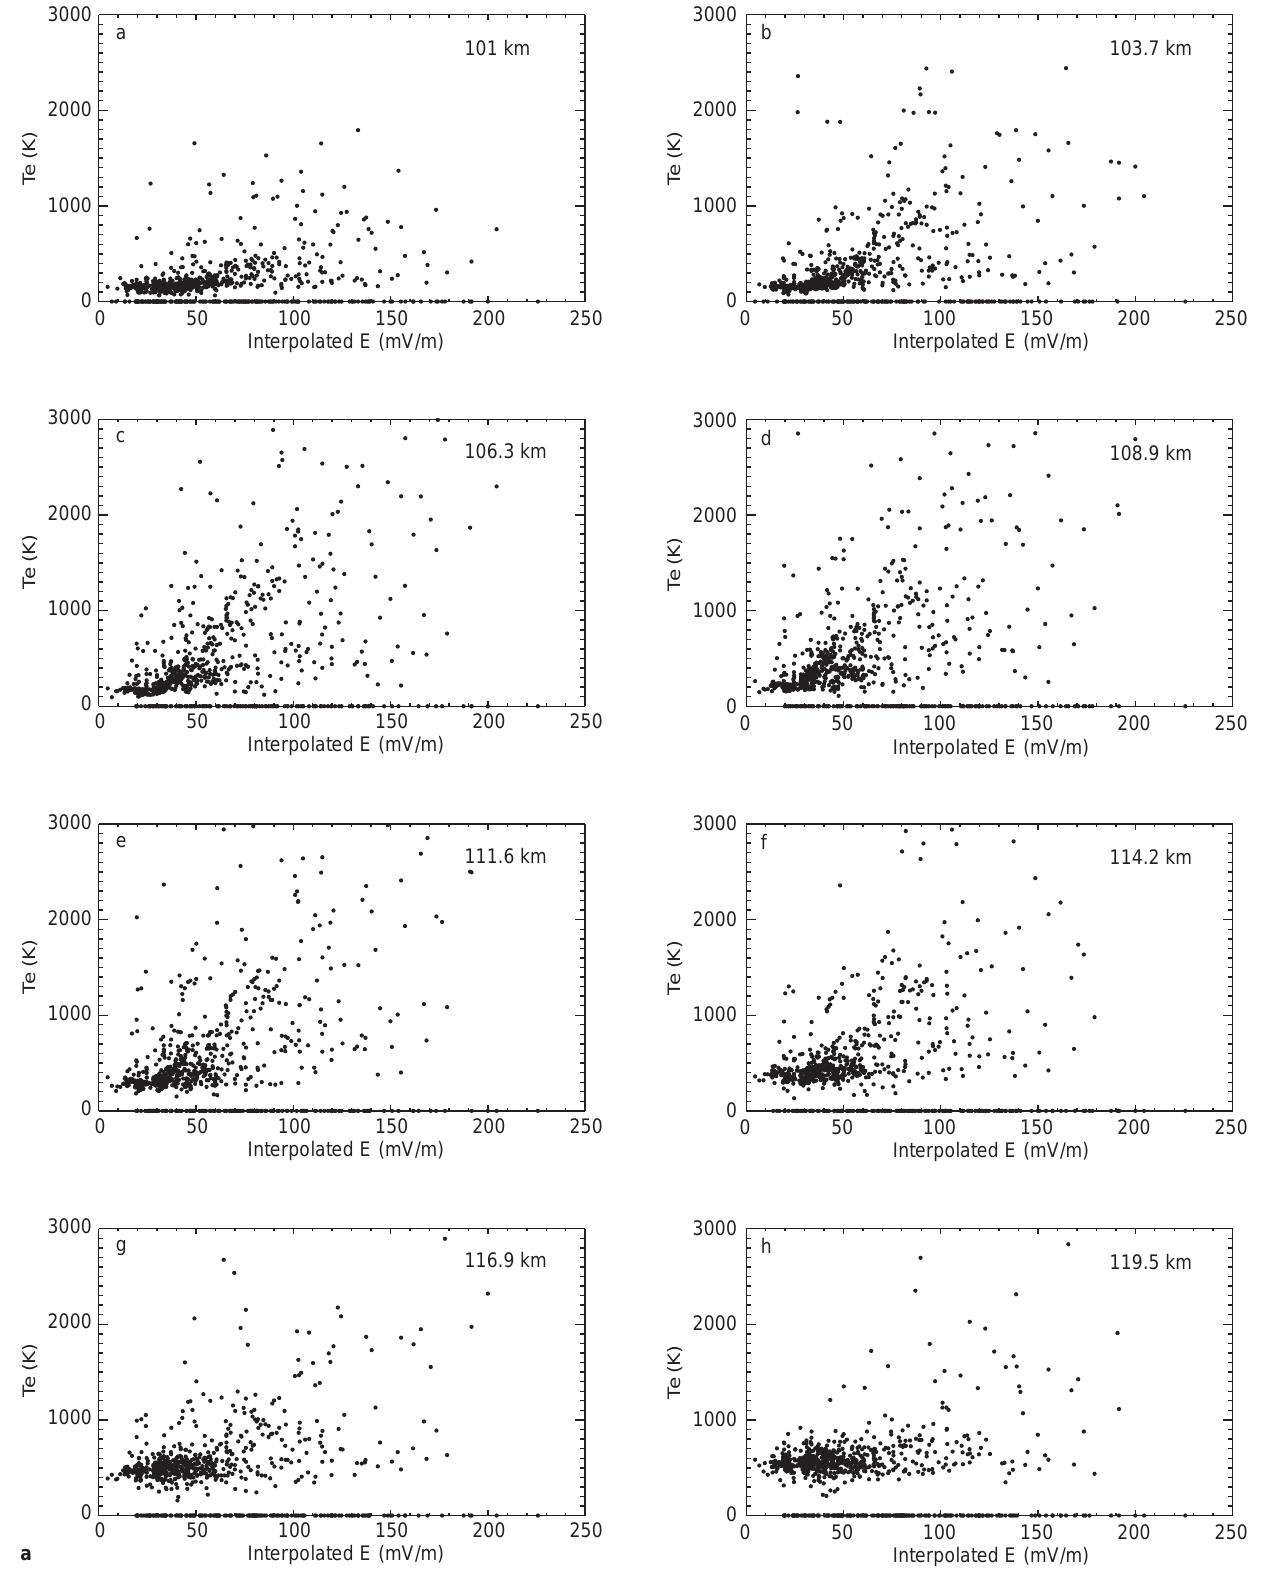
Fig. 3a. Scatter plot of T e vs E at 8 di(cid:128)erent altitudes for the time period 22:00 UT to 35:00 UT. The altitudes are 101 km ( a ), 103.7 km ( b ), 106.3 km ( c ), 108.9 km ( d ), 111.6 km ( e ), 114.2 km ( f ), 116.9 km ( g ), and 119.5 km ( h ). Bad data points were given zero